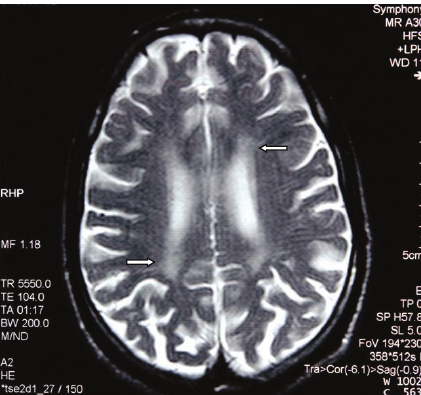
Figure 2: Axial T2 weighted MR image of the brain at the level of the basal ganglia. There is symmetric hypointensity of the thalami (straight arrow) as well as hyperintensity of the posterior limbs of internal capsule (curved arrow). Cerebral atrophic changes also noted with rounded horns of lateral ventricles. Normal variant cavum septum pellucidum and vergae noted (arrow head).